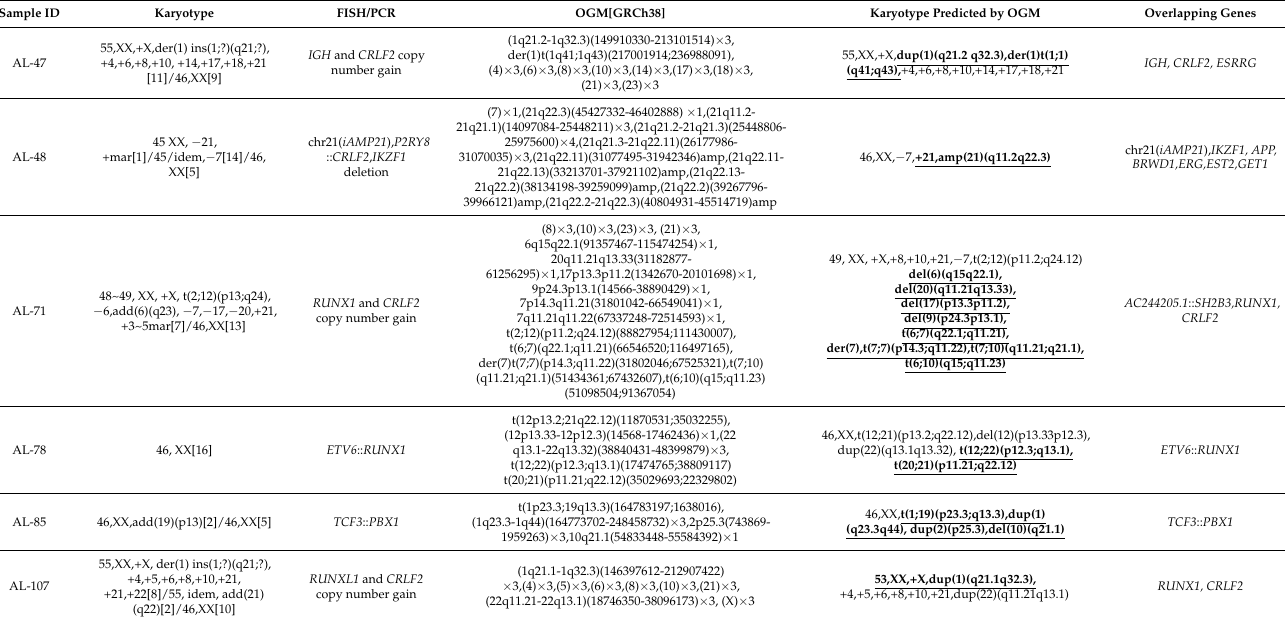
Table 3. Refining Cytogenetic Breakpoints and Resolving Unknown Cytogenetic Elements by